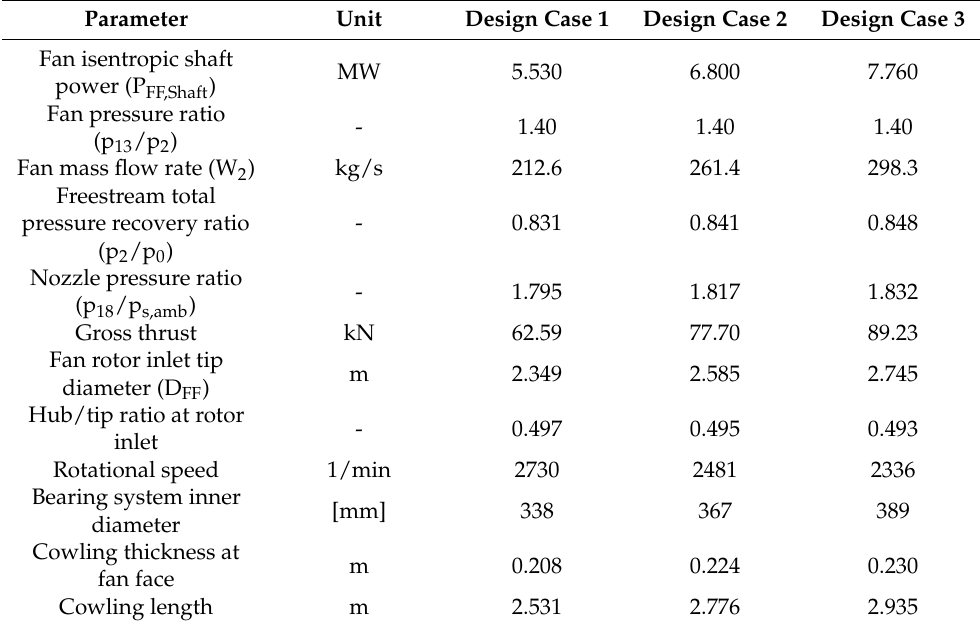
Table 4. Summary of results for actual FF flow path sizing (M0.82, FL350, ISA +